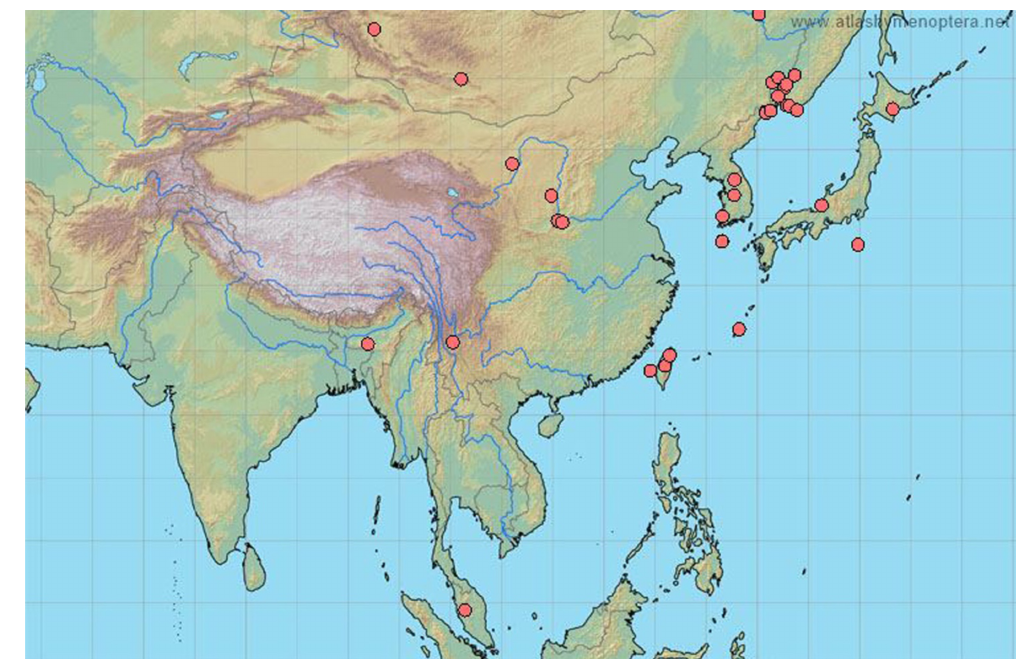
Fig. 11. Geographical distribution of Lasioglossum villosulum trichopse (Strand, 1914) .